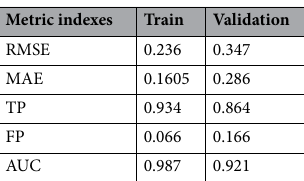
Table 3. Results of the model performance.